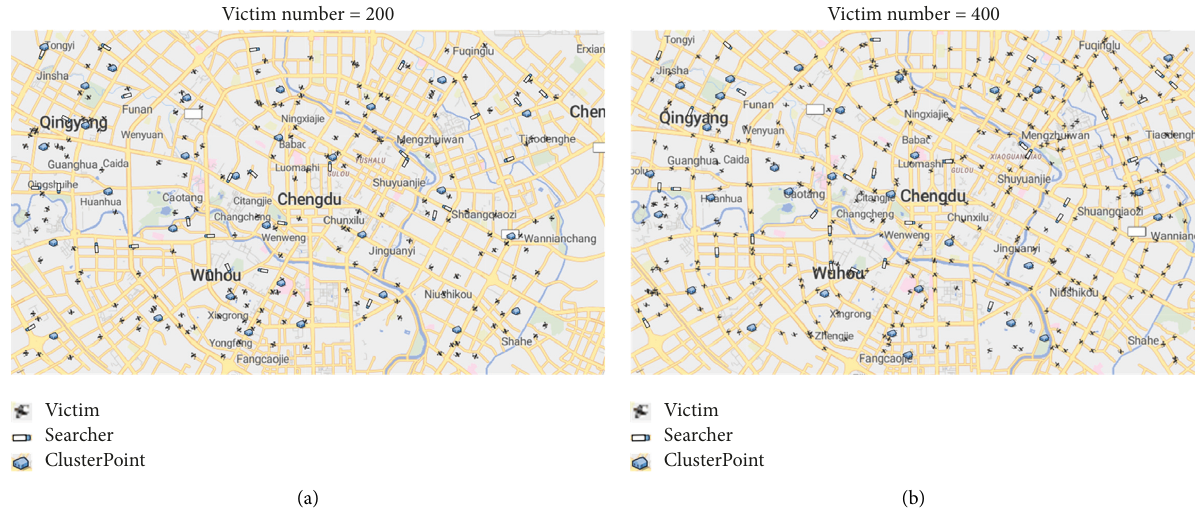
Figure 8: The experiment environment of the ERSCIED (200 victims (a) and 400 victims